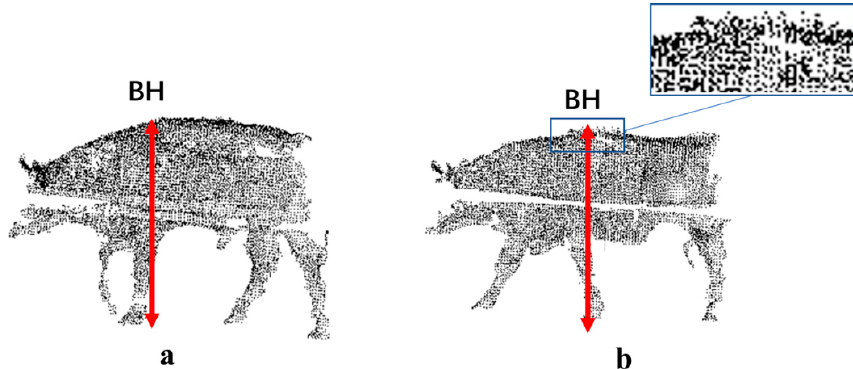
Figure 21. Two enlarged wither height cases. (( a ) Animal with an arched back, ( b ) animal with hair lift).